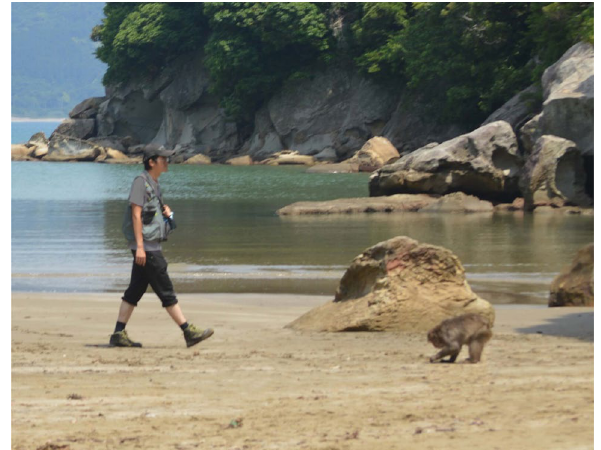
Figure 1. Position of experimenter 1 (E1) and subject (S) during an experimental trial in Experiment 1. E1 stands approximately 5 m in front of S, emits a soft vocalization so that S notices his presence and walks toward S at a constant speed (approximately 1 m/s). There were two conditions: Direct gaze towards S and Averted gaze towards the